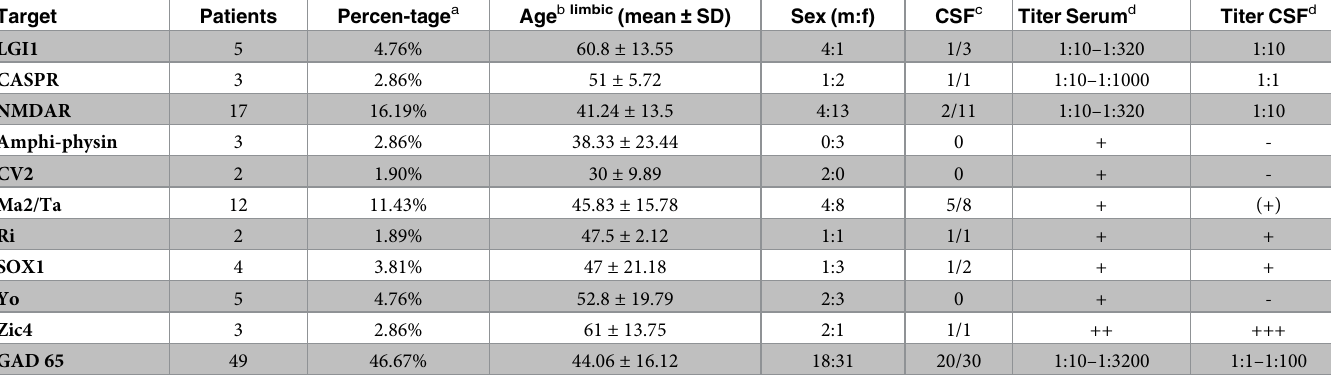
Table 1. Presence and distribution of neuroABs in 800 TAOS patients. Target